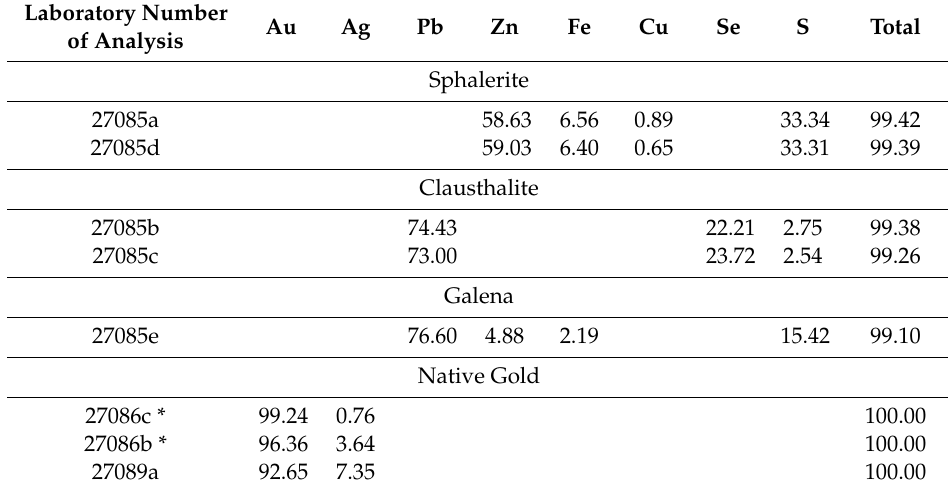
Table 2. Chemical composition of some accessory and rare minerals of the Ashadze-2 hydrothermal field, wt